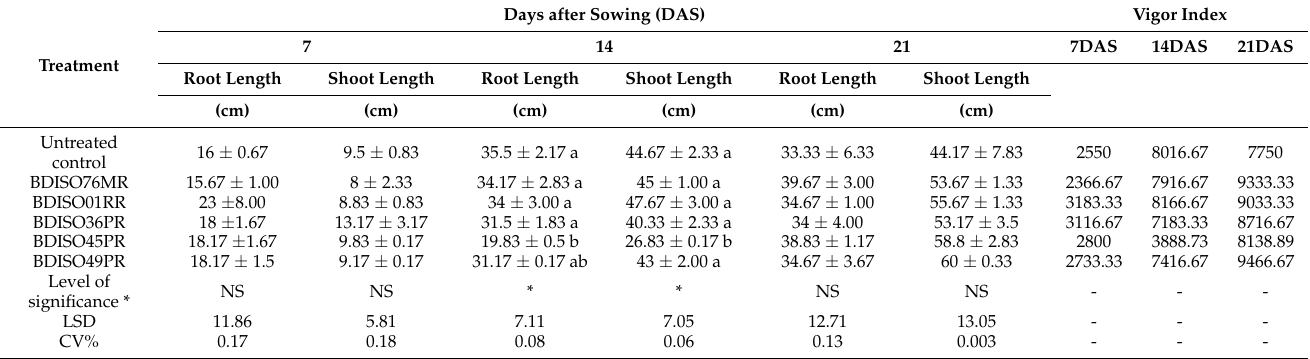
* Represents significance at a 5% level of significance. Data are the averages of three replications ± SE. Values with similar letters are not significantly different at a 5% level of significance. (BDISO76MR: B. subtilis , BDISO01RR: B. amyloliquefaciens , BDISO36PR: B. subtilis , BDISO45PR: B. subtilis and BDISO49PR: B. subtilis ). Untreated control: seed treatment with only distilled water. At 14 DAS, maize seeds treated with BDISO76MR ( B. subtilis MMM1) demonstrated the maximum (34.17 cm) root length which was statistically similar to BDISO01RR ( B. amyloliquefaciens ) (34 cm), BDISO36PR ( B. subtilis ) (31.5 cm), and BDISO49PR ( B. subtilis ) (31.17 cm) (Table 5). The minimum (19.83 cm) root length was observed for the isolate BDISO45PR ( B. subtilis ) (Table 5). For shoot length at 14 DAS, the maximum (47.67 cm) shoot length was observed when maize seeds were treated with BDISO01RR ( B. amyloliquefaciens ), which was statistically similar to BDISO76MR ( B. subtilis MMM1) (45 cm), BDISO49PR ( B. subtilis ) (43 cm), and BDISO36PR ( B. subtilis ) (40.33 cm), while the minimum (26.83